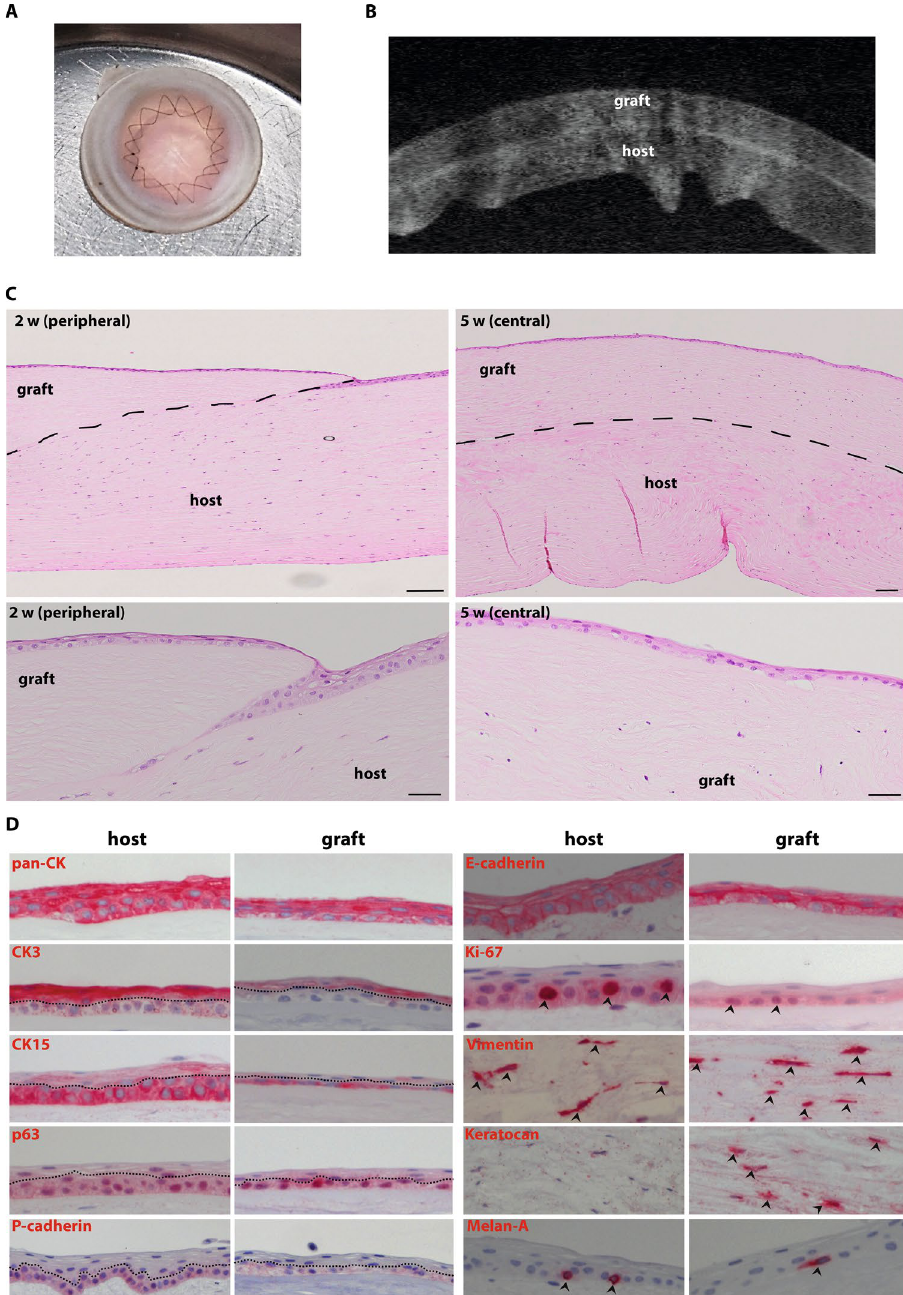
Figure 5. Ex Vivo transplantation of decellularized human cornea (DHC) ( A ) micrograph of DHC transplanted ex vivo in the normal human cornea (NHC) as anterior lamellar grafts with double running cross-stitch sutures. ( B ) AS-OCT micrograph showing the well-adapted graft (DHC) and host tissue (NHC) and no gap was observed in between. ( C ) After 2 weeks (2 w) of transplantation, histological analyses by hematoxylin and eosin (H&E) staining showed complete epithelialization of graft tissue with stratification and absence of stromal cells in graft tissue (2 w) (dashed line marking the boundary between the graft and host tissue). The stromal cells appeared in the graft region at 5 weeks samples confirmed by H&E staining (5 w). Scale bar—100 µm D) Immunohistochemical staining on paraffin sections showing the cytokeratin (pan-CK) expression on epithelial layers; CK3 expression on suprabasal cells; CK15, P(placental)-cadherin, p63 (dotted line separated the basal and superficial cells), and Ki-67 expression at basal layers of epithelial cells (arrowheads); E(epithelial)-cadherin expression in all epithelial layers; vimentin expression in the stromal region (arrowheads); and Melan-A expression (magenta) (arrowheads) on melanocytes at basal layers of epithelium, in both host and graft tissue. A keratocan expression was observed only in the graft tissue (arrowheads). AS-OCT anterior segment optical coherence tomography, pan-CK pan-cytokeratin, CK3 cytokeratin 3, CK15 cytokeratin